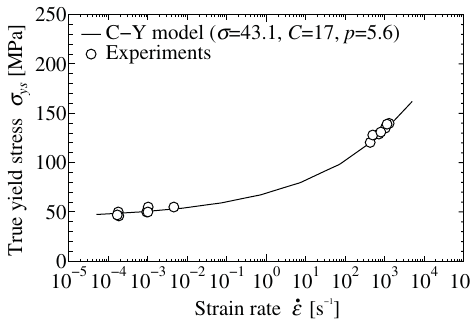
Fig. 6. Strain rate dependency of stress at yield onset.